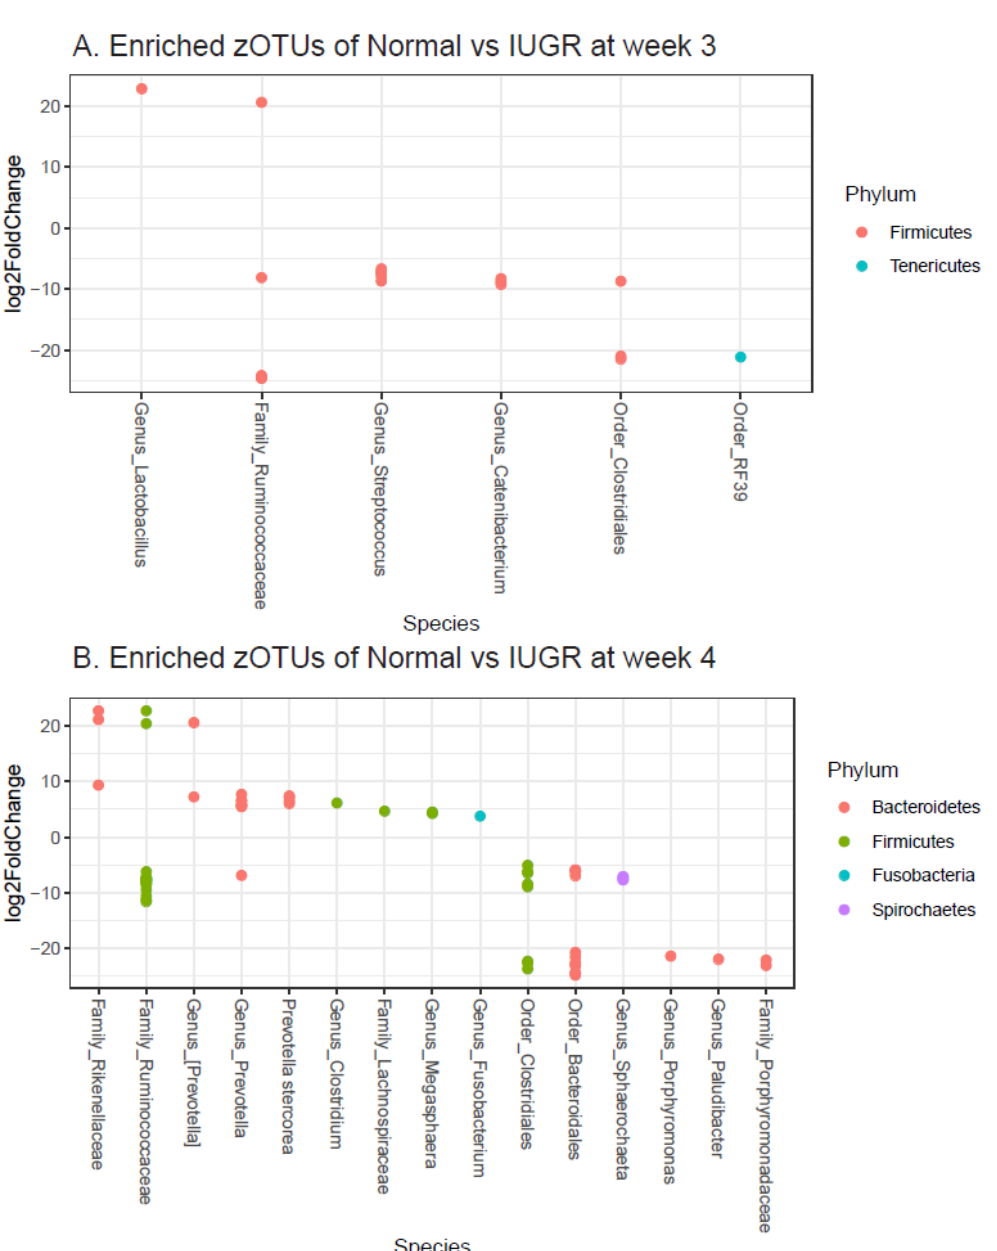
Figure 2. ( A , B ) Statistically enriched zero-radius operational taxonomic units (zOTUs) in normal and intrauterine growth-restricted (IUGR) at week 3 ( A ) and week 4 ( B ). Log2Foldchange represents the abundance fold change of normal piglets with respect to IUGR after log2 transformation.